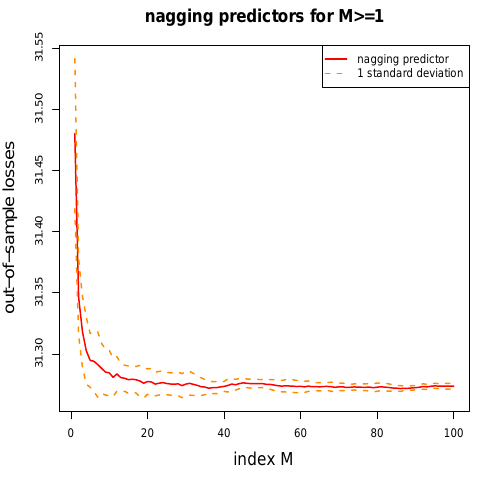
( M ) averaged over T for M = 1, . . . t